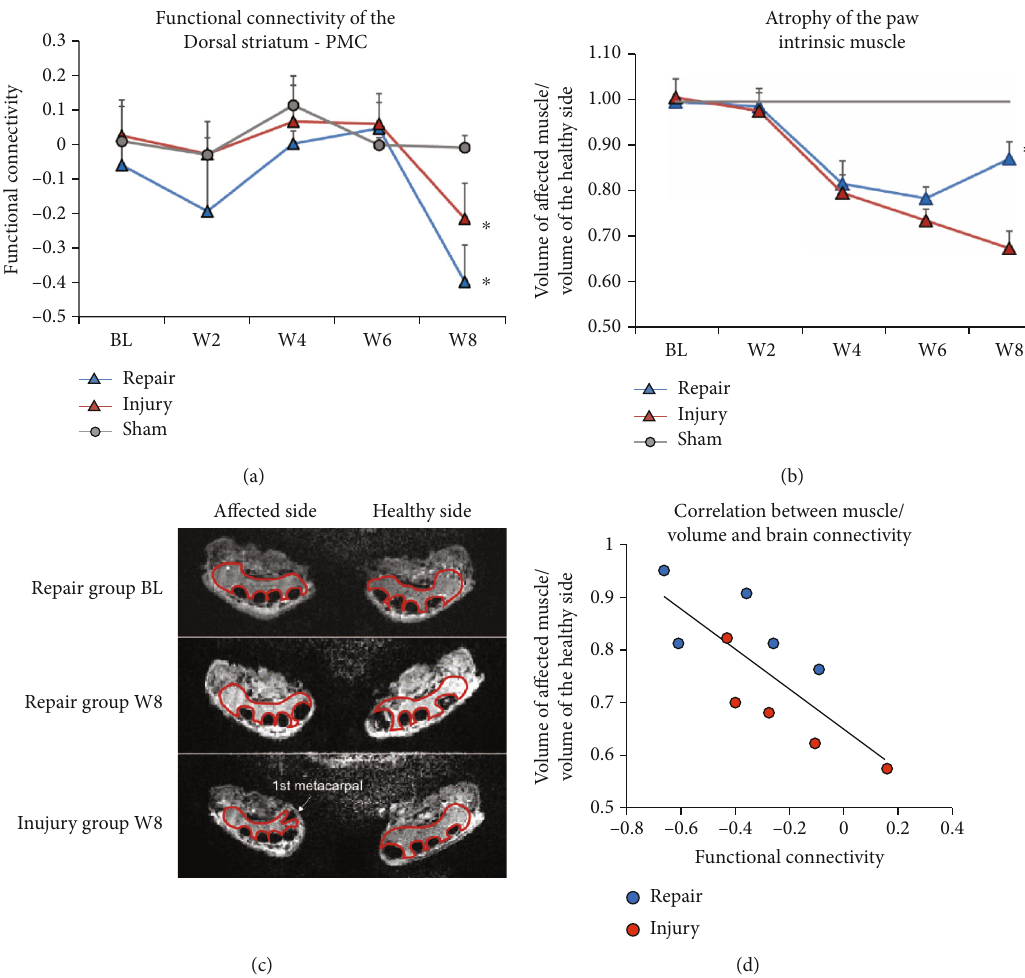
Figure 5: The change of dS-M1 connectivity and paw muscle atrophy following PNR. (a) The FC of the dS-M1 remains similar among the three groups until week 8, when the FC of the nerve injury and the repair group was statistically di ff erent from that of the sham group. (b) The degree of muscle atrophy was gradually aggravated from week 2 postsurgery in the nerve injury and repair groups. However, the nerve repair group demonstrated only partial recovery of muscle volume at week 8. (c) The muscle atrophy of the repair and the injury groups was shown in an exemplary graph. Note that remarkable muscle atrophy of the injured side was observed at week 8 in the injury group, but not in the repair group. The adduction of the 1st metacarpal was also observed due to the thenar atrophy of the paw. (d) We observed a signi fi cant correlation between the dS-M1 FC and the degree of muscle atrophy in rats with nerve injury and repair at week 8. ∗ p < 0 : 05 compared to the